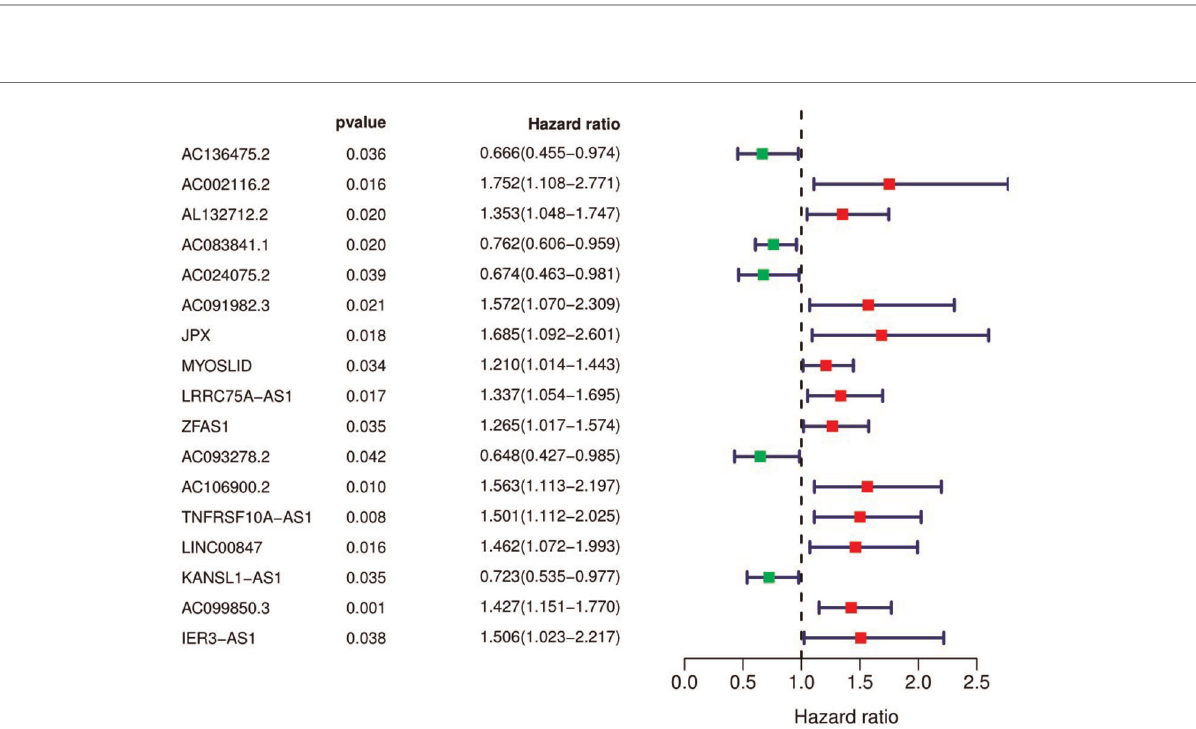
FIGURE 2 Pyroptosis-related long non-coding RNAs affecting overall survival of patients with OSCC. 95% CI, 95% con fi dence